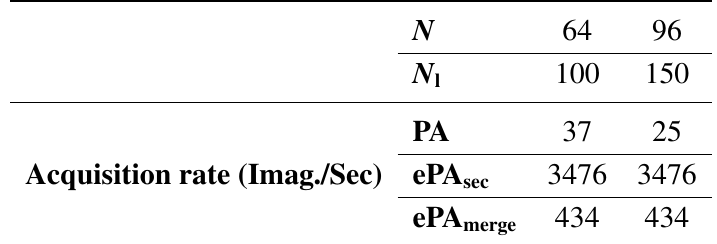
Table 5. Acquisition time for an angular sector β = 90 ◦ and a maximum range depth R = 20 cm, obtained with the PA and the ePA for array sizes of N = 64 and max N = 96